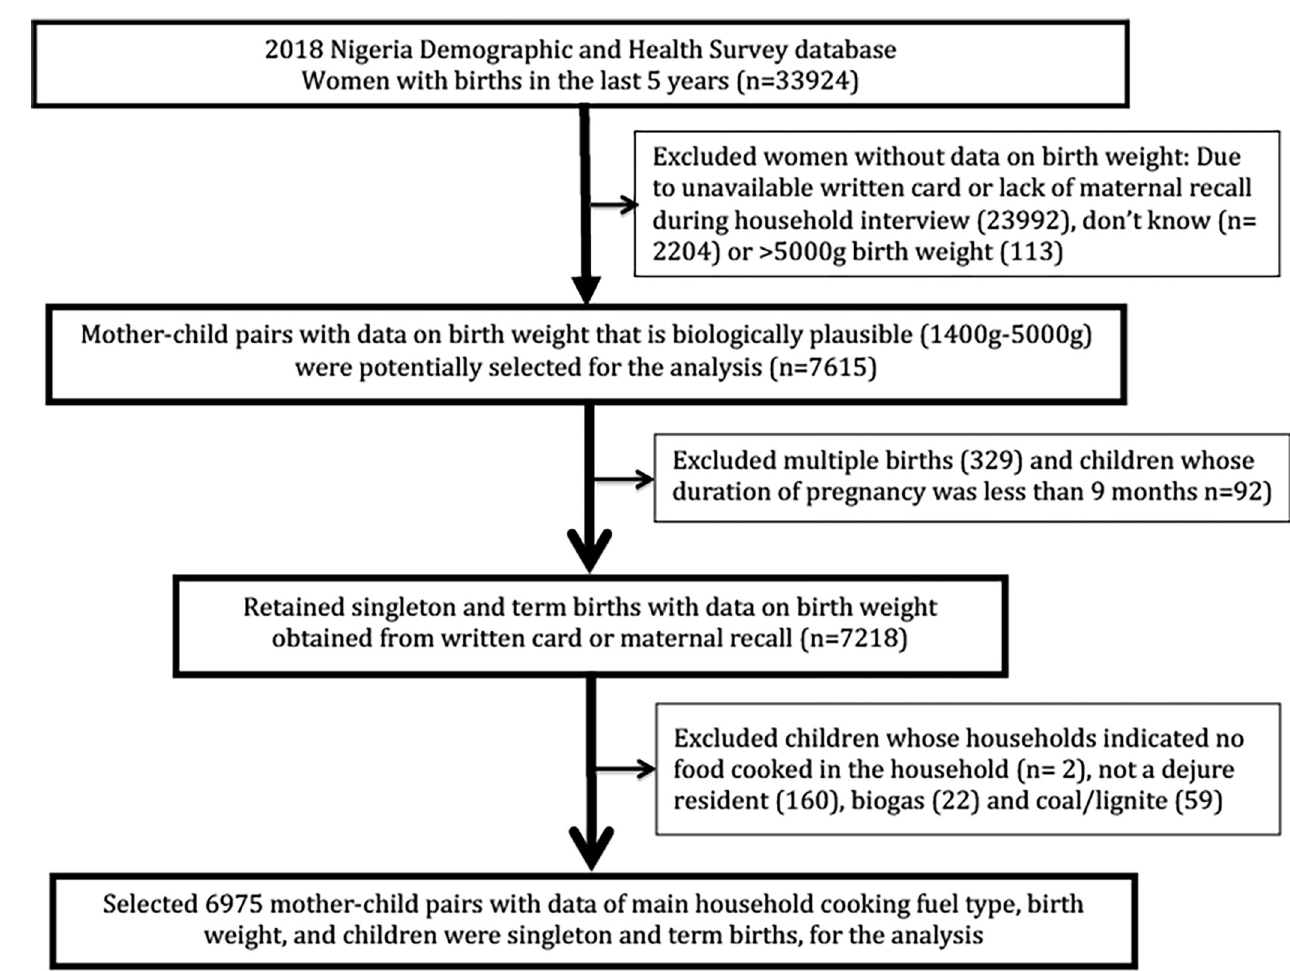
Fig 2. Participant selection flowchart from the 2018 Nigerian